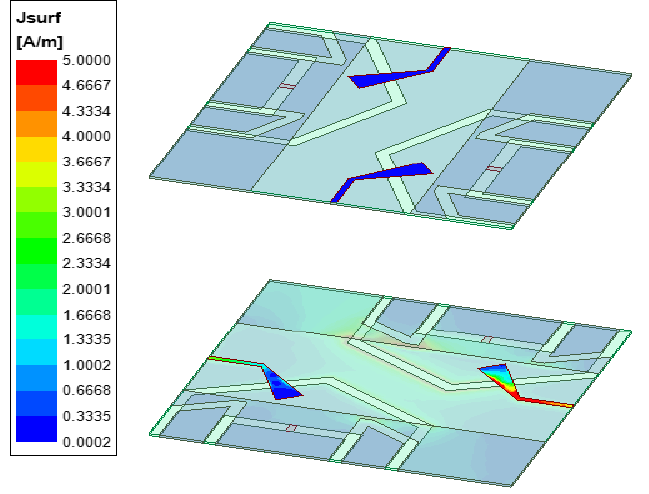
Figure 6. Fabricated antenna current density distributions (top and bottom view).